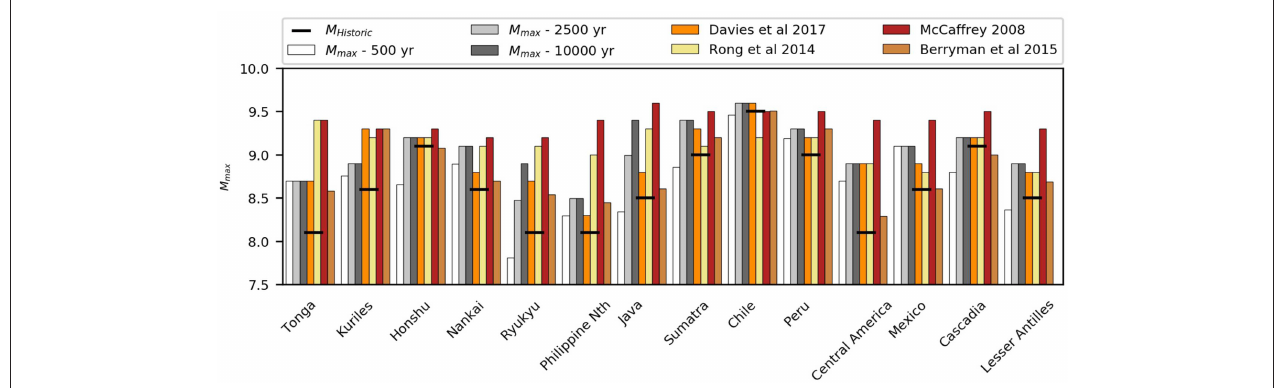
FIGURE 7 | Comparison of some M max estimates based on this study for various return periods and literature results of Rong et al. (2014), McCaffrey (2008), Berryman et al. (2015) and Davies et al. (2017). In addition, black lines indicate so-far observed historic records of maximum